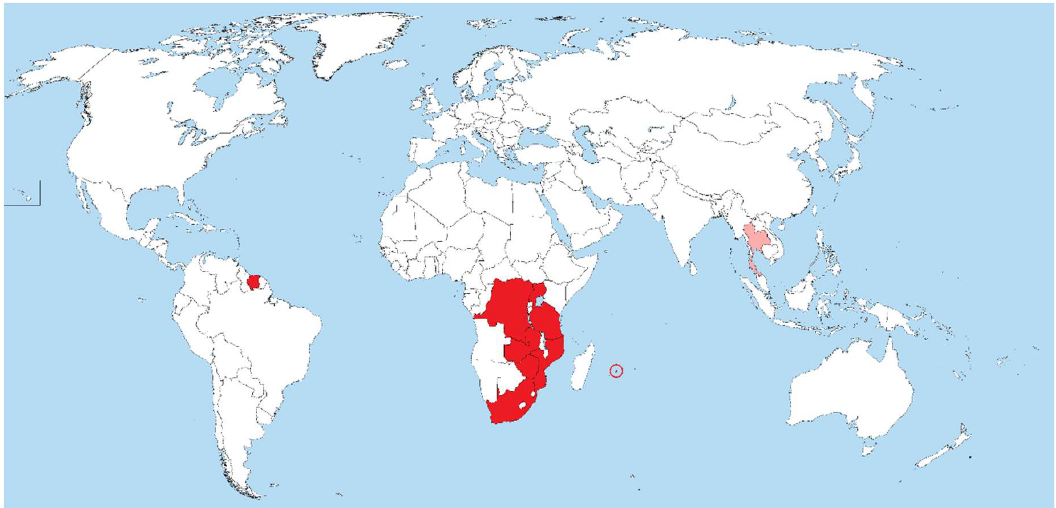
Figure 1. Map of the world showing countries (in red fill) where Ternidens deminutus infection in humans has been confirmed (red circle = Mauritius; pink fill = single case report, possible misidentification of Oesophagostomum infection).